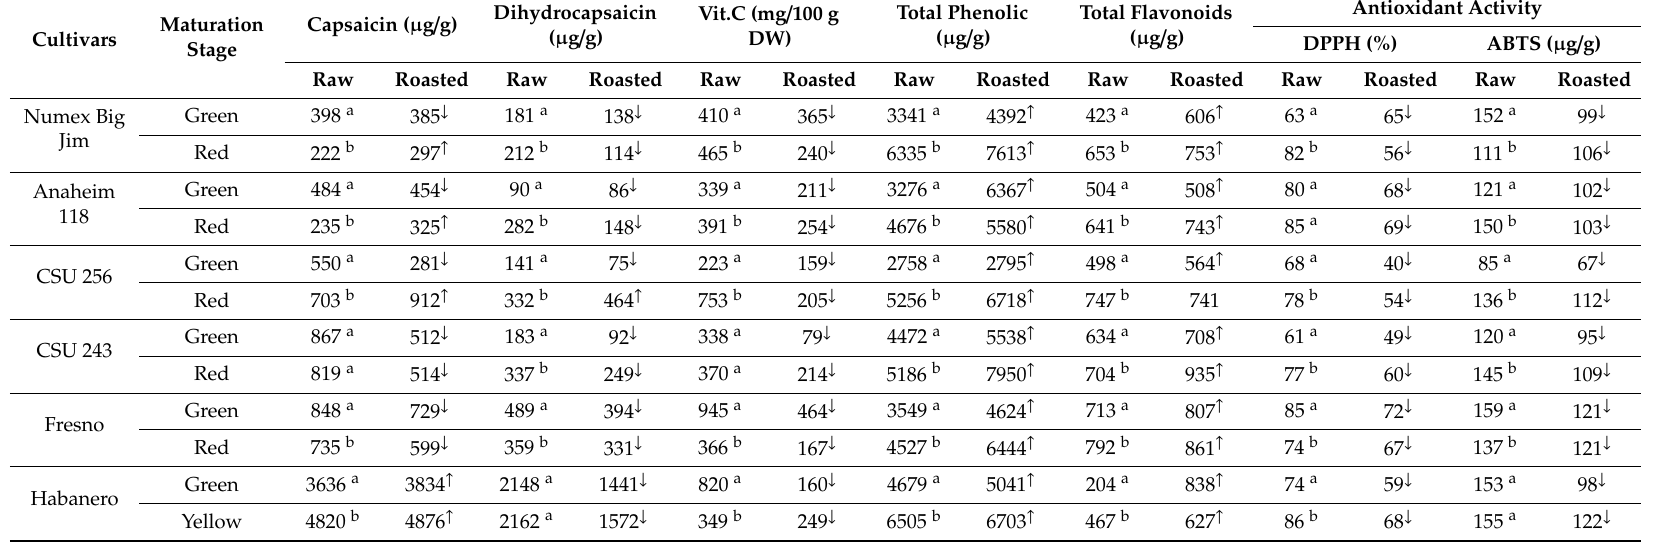
Table 2. Change in content of capsaicinoid compounds in pepper pods as a function of ripening stage and cooking. E ff ect of roasting on the nutrient contents in C. annuum and C. Chinense viz.